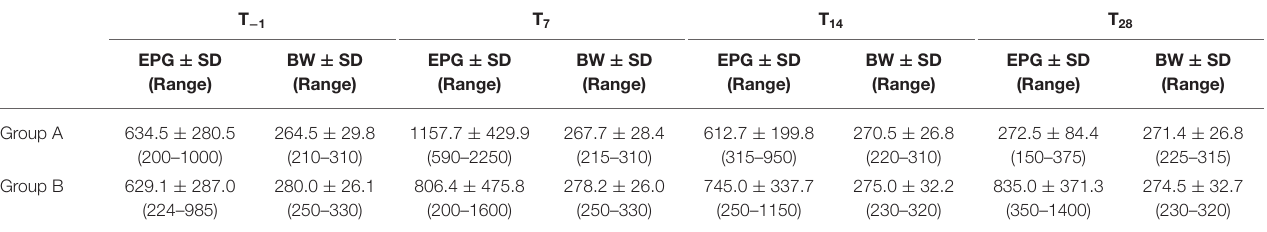
TABLE 1 | Mean values and standard deviation (SD) of egg per gram of feces (EPG) and body weight (BW) recorded in treated (Group A, n = 11) and untreated (Group B, n = 11) donkeys at study time-points (T − 1 -T 28 ). T − 1